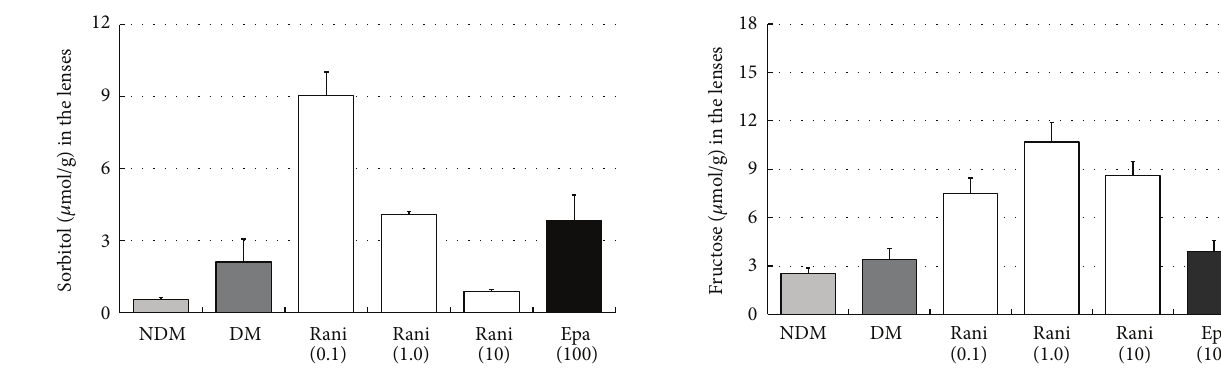
Figure 7: The sorbitol levels in the lenses at 15 weeks. Although there seems to be a dose-dependent decrease in the sorbitol levels in the lenses with administration of ranirestat, the sorbitol levels in the untreated lenses and in the lenses treated with epalrestat are very low. NDM: non-diabetes mellitus; DM: diabetes mellitus; rani: ranirestat; epa: epalrestat.